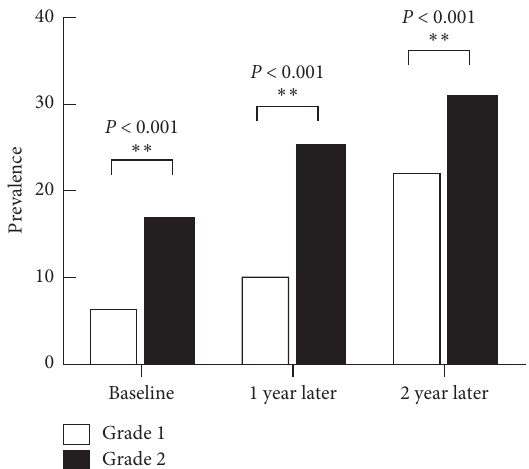
Figure 1: Prevalence of myopia among children of 7 years of age in grade 1 and grade 2.